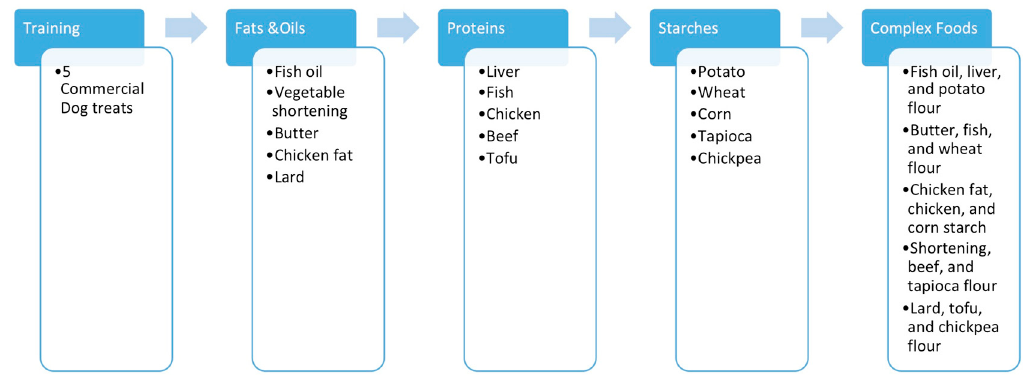
Figure 1. Visualization of the test flow in phases 1 (Training) to 5 (Complex Foods).